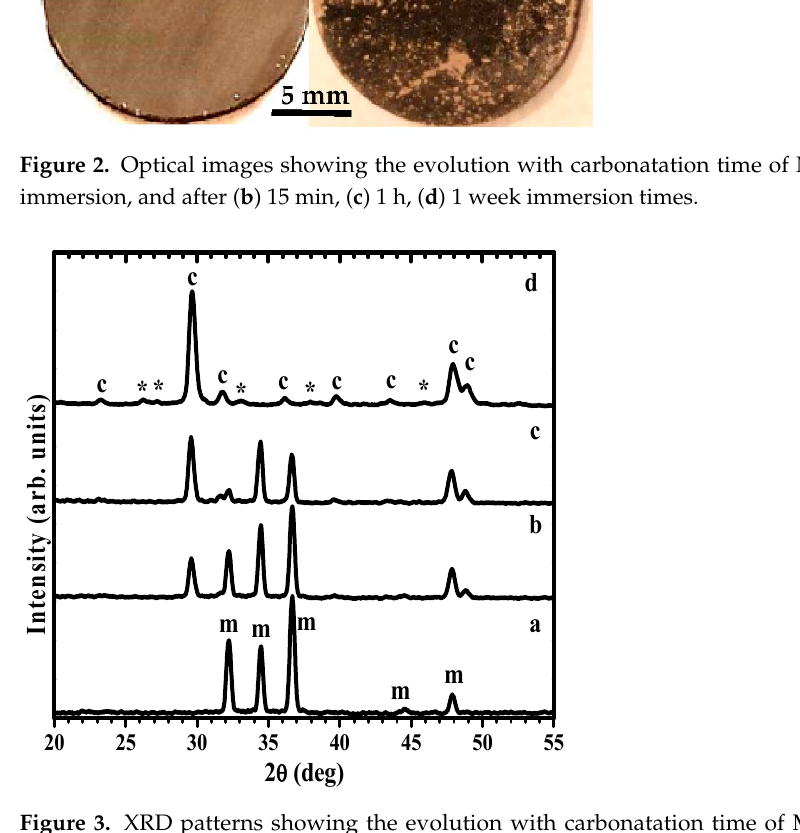
Figure 3. XRD patterns showing the evolution with carbonatation time of Mg disks: ( a ) before immersion, and after ( b ) 1 h, ( c ) 1 day, ( d ) 1 week immersion times (c: calcite; *: aragonite; m: Mg).